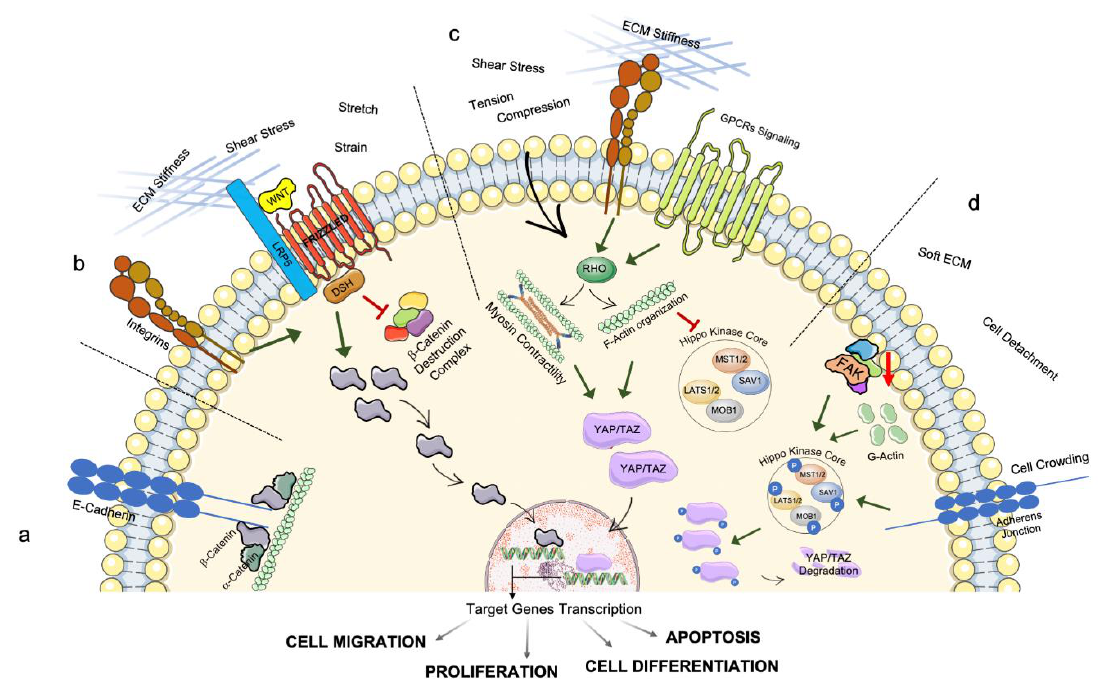
Figure 2. Schematic representation of the principal biochemical pathways that mediate mechanotransduction: ( a ) β -Catenin at the membrane level binds E-Cadherin and contributes to cellular adhesion; ( b ) Activation of the Wnt/ β -Catenin pathway: Wnt ligands and mechanical stimuli mediated by integrins inhibit the β -Catenin destruction complex and induce β -Catenin translocation to the nucleus where its leads to transcription of target genes involved in diverse cellular functions; ( c ) Activation of YAP/TAZ nuclear translocation and transcriptional co-activator function is induced by ECM mechanical properties and external mechanical stimuli, which are sensed by the cell through the integrins and GPCRs signaling routes; with the mediation of the RHO GTPase pathway, F-Actin formation and contractility through Myosin II induce YAP/TAZ nuclear translocation and inactivation of the Hippo kinase core, allowing transcription of target genes; ( d ) Mechanical stimuli such as cellular detachment, soft ECM, together with excessive formation of adherens junction due to cell crowding and inhibition of FAK or F-Actin formation, cause YAP/TAZ inhibition due to phosphorylation of the core Hippo kinases and of YAP/TAZ, leading to their cytoplasmatic degradation. Red arrow down ↓ indicates downregulation. DSH, Dishevelled; FAK, Focal Adhesion Kinase; LATS1/2, large tumor suppressor kinase 1 and 2; LRP5, LDL Receptor Related Protein; MOB, MOB kinase activator 1; MST1, Ste20-like kinase 1; RHO, Ras homologous; SAV1, Salvador homolog 1; TAZ, transcriptional co-activator with PDZ-binding motif; WNT, Wingless/Integrated; YAP, Yes-associated protein 1.